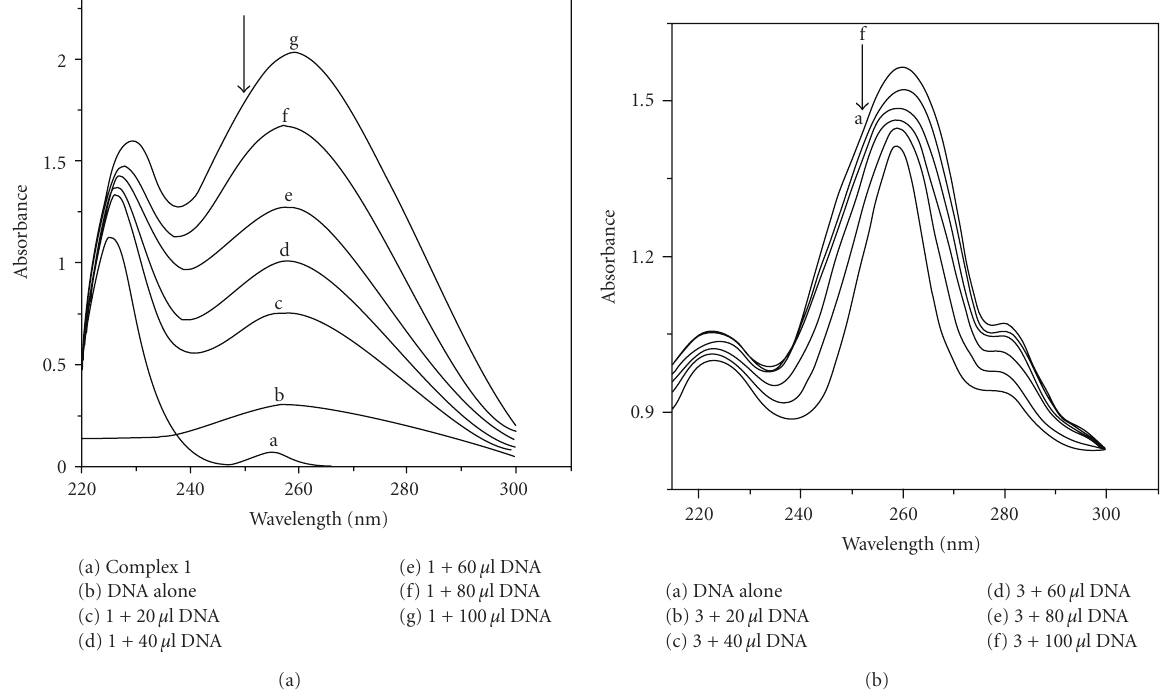
Figure 4: Absorption spectra of (a) complex 1 (5.0 × 10 − 5 M) and (b) complex 3 (5.0 × 10 − 5 M), in Tris-HCl bu ff er upon addition of DNA = 0.5 μ M, 0–100 μ L. Arrow shows the absorbance changing upon increasing the concentration of DNA.